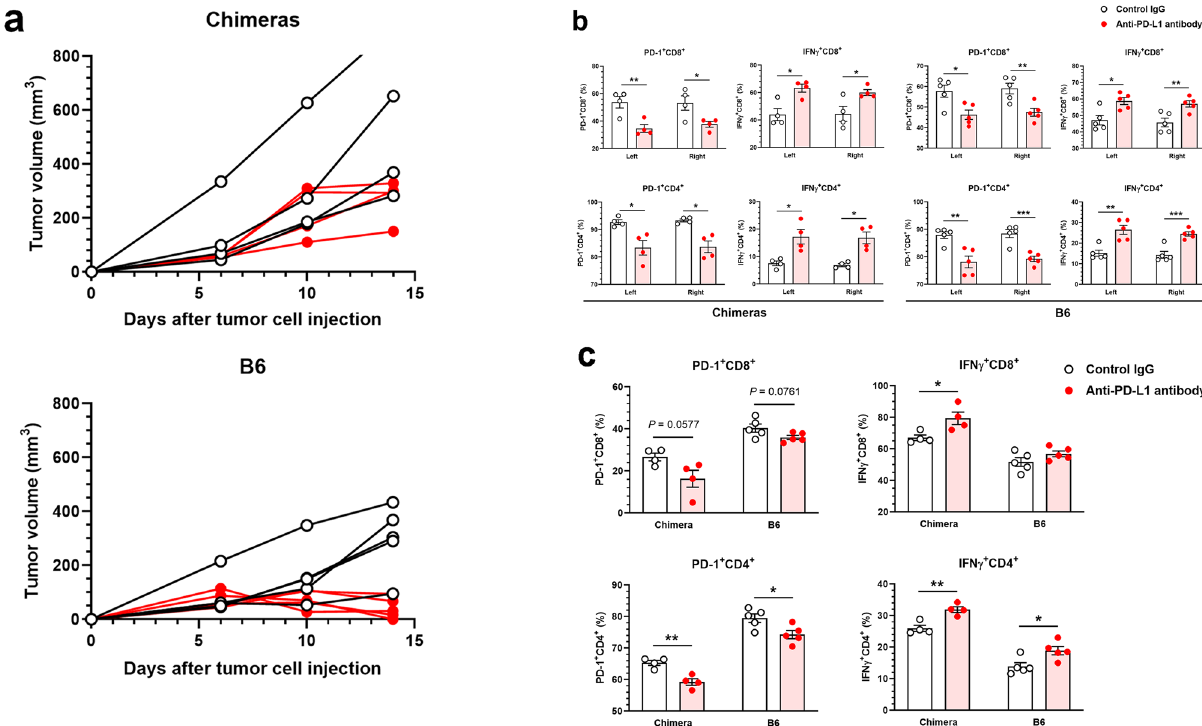
Figure 6. Antitumor effects of anti-PD-L1 antibody on tumors engrafted in C57BL/6 J (B6) and B6 ESC CAG-Azami-green → CD1- Foxn1 nu / nu chimeric mice. MC38 cells (B6-derived cancer cells syngenic to the donor of the thymus-complemented chimeric mice), were inoculated subcutaneously into the right flank of B6 mice and chimeras at 1 × 10 6 cells/head (day 0), and tumor volumes were measured on days 6, 10, and 14. Anti-PD-L1 antibody (50 μg/100 μL/mouse) or control IgG (50 μg/100 μL/mouse) was administered intraperitoneally on days 7 and 10. On day 14, draining lymph nodes (dLNs) and tumors were harvested for flow cytometry (FCM) analysis. ( a ) Tumor growth curves of individual chimeric mice and B6 mice (open black circles, control IgG; filled red circles, anti-PD-L1 antibody). ( b ) Percentages of PD-1 + CD4 + and PD-1 + CD8 + T cells and IFNγ + CD4 + and IFNγ + CD8 + T cells in the left and right dLNs of chimeras and B6 mice. ( c ) FCM analysis of tumor- infiltrating lymphocytes (TILs) of chimeras and B6 mice. Percentages of PD-1 + CD4 + and PD-1 + CD8 + TILs and IFNγ + CD4 + and IFNγ + CD8 + TILs were compared between the control and anti-PD-L1 antibody treatments. Values were analyzed by F -test, followed by an unpaired two-tailed Student’s t -test or two-tailed Welch’s t -test between treatments. *, **, and *** indicate P < 0.05, P < 0.01, and P < 0.001, respectively. Means ± S.E.M. n = 4 for each group of chimeras; n = 5 for each group of B6